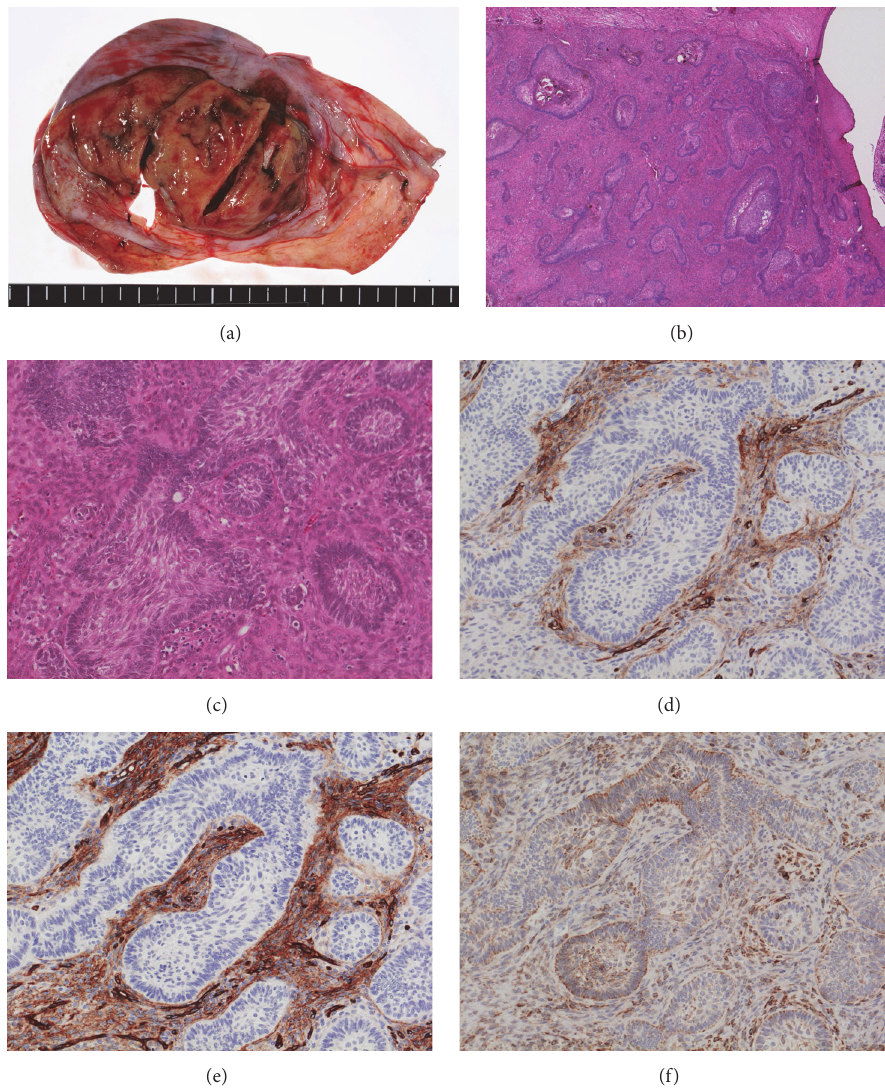
Figure 3: Macroscopic and pathologic findings. (a) Macroscopic findings. (b) Hematoxylin and eosin staining (magnification × 30). (c) Hematoxylin and eosin staining (magnification × 150). (d) Immunohistochemistry, showing positive results for CD10 (magnification × 150). (e) Immunohistochemistry, showing positive results for CD34 (magnification × 150). (f) Immunohistochemistry, showing positive results for Bcl-2 (magnification ×